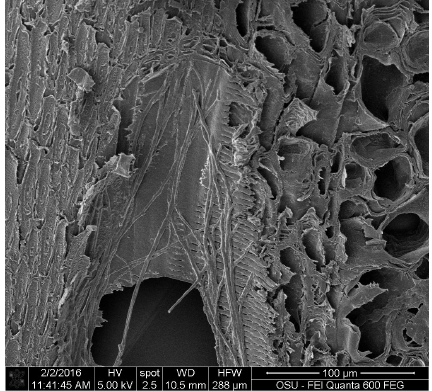
Figure 1. S. cuboideum hyphae developing inside a bamboo vessel on week 16.